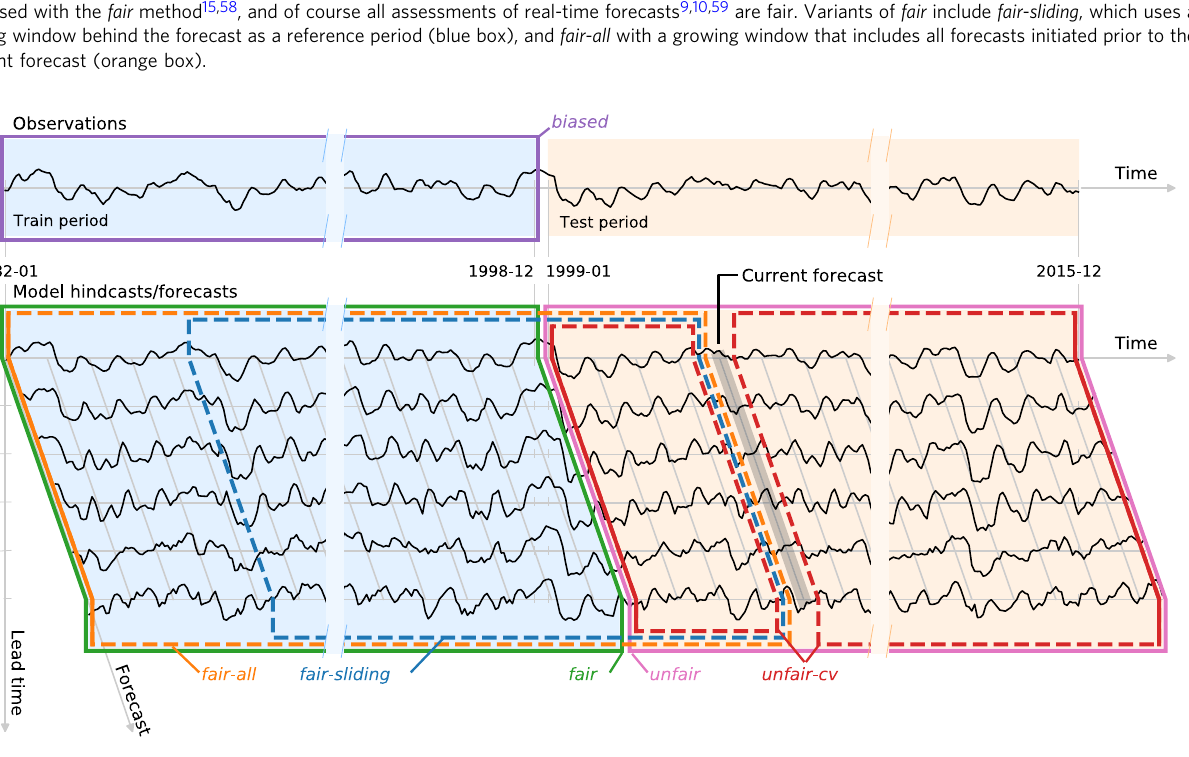
Fig. Box 2: Schematic bias correction plot. The schematic shows a time series of the observed variable at the top and hindcast/forecast time series at different lead times (to 11 months) on the bottom. The time series are divided in half to give a training period (blue shade) and a testing period (tan shade). The training period is typically reserved for computing the model climatology of the forecasts, and the testing period is used to test the bias- corrected forecasts. The coloured lines depict the periods used in forming the reference climatologies for the different bias correction methods described above. Solid lines indicated fi xed periods. Dashed lines indicate periods that move as the forecast start date